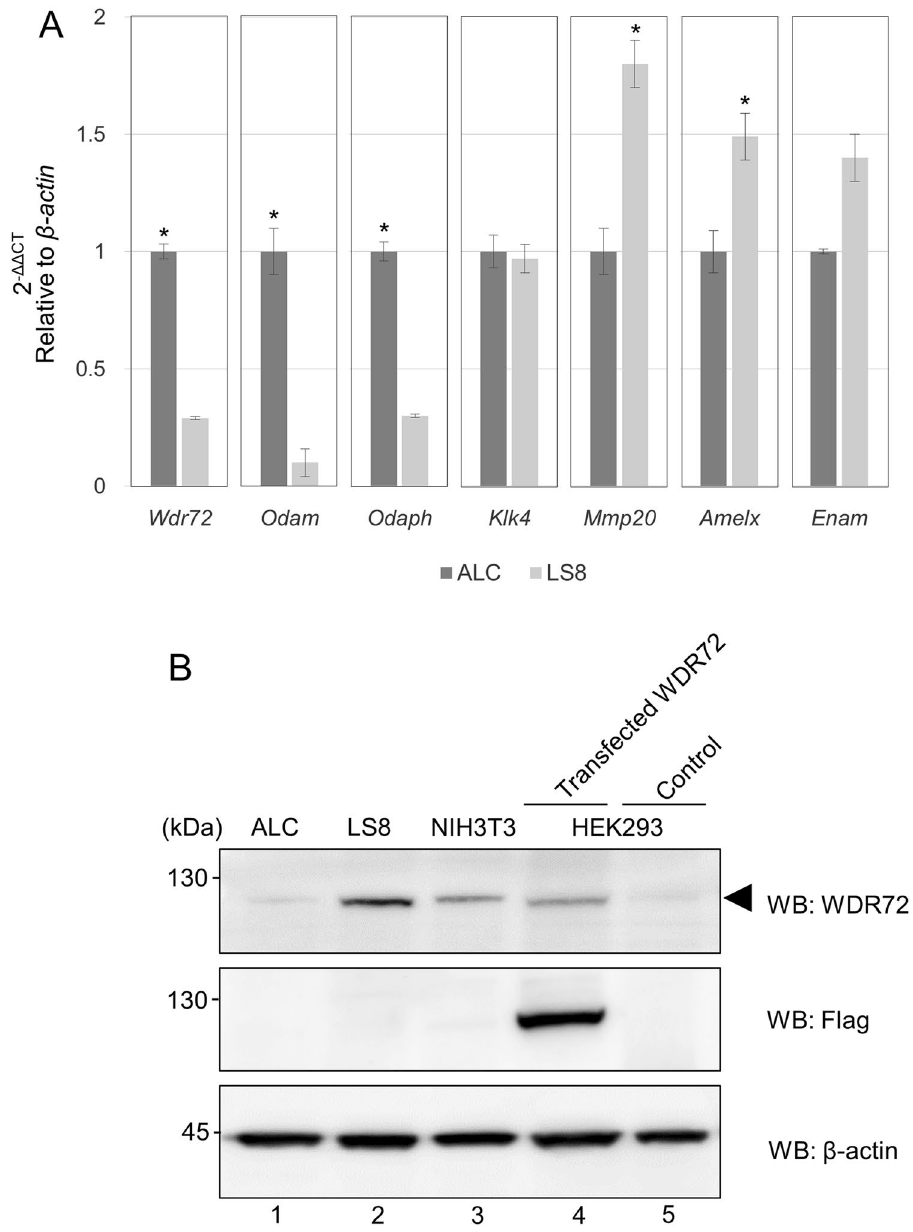
Figure 2. Expression of Wdr72 in ALC and LS8 cells at RNA and protein levels. ( A ) Gene expression of Wdr72 . The expression levels of amelogenesis gene markers at maturation stage ( Odam , Odaph and Klk4 ) and those at secretory stage ( Mmp20 , Amelx and Enam ) were measured, normalized to that of β-actin and compared between ALC and LS8 cells. The normalized value in ALC cells in each gene expression was used as a calibrator. The values are shown as the mean ± SD based on the averages of three independent experiments with triplicates in each. The values in each marker were compared between ALC and LS8 and statistically analyzed by student T-test. An asterisk represents a statistically significant difference between the values of ALC and LS8 in each marker ( p < 0.01). ( B ) Protein expression of WDR72. Western blot analysis (WB) was performed using ALC, LS8 and NIH3T3 cell extracts to investigate the expression of WDR72 protein by anti-WDR72 antibody. The HEK293 cells were transiently transfected with Flag-tagged human WDR72 wild-type expression vector or an empty vector, and the lysates were used as a positive control (Lane 4, Transfected WDR72) and a negative control for transfection (Lane 5, Control). Western blot analysis by anti-Flag antibody was also performed to confirm the presence of Flag-WDR72 protein. The expression of β-actin was shown as a loading control. The experiment was repeated three times and representative images are